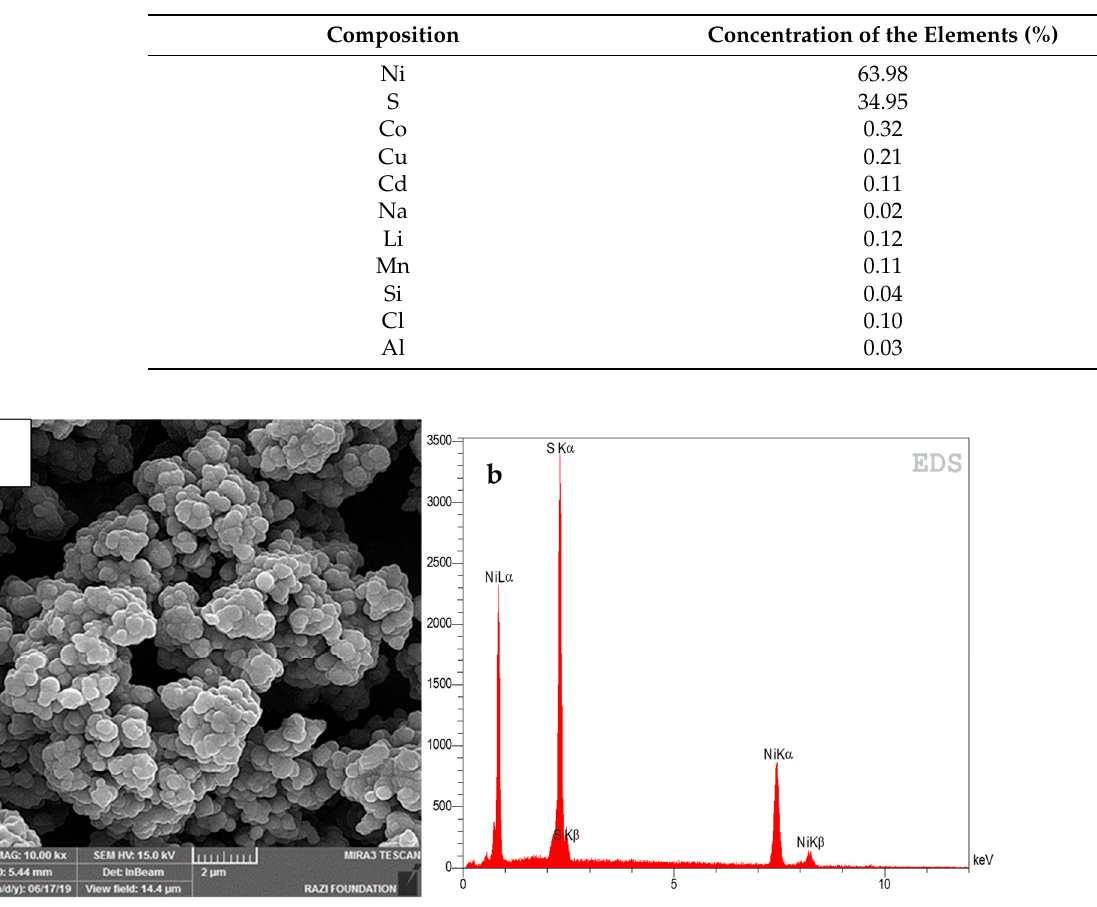
Table 3. ICP-OES and wet chemical analysis of the as-fabricated NiS nanoparticles.